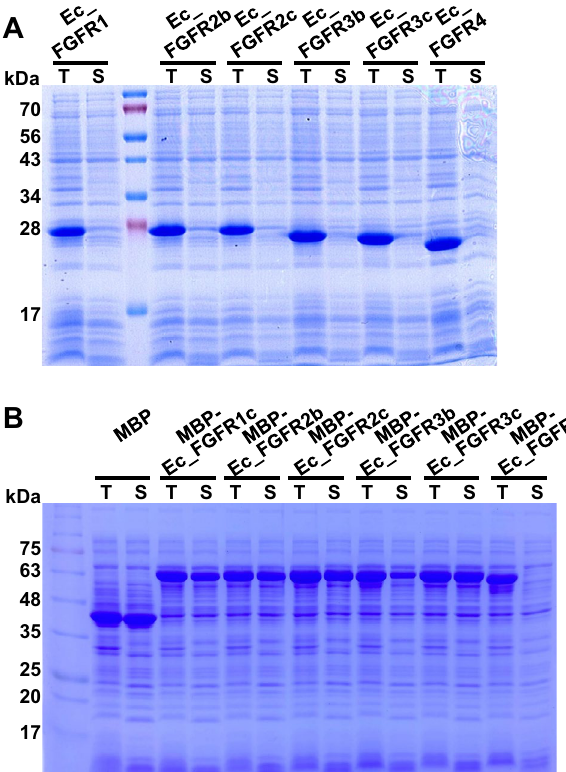
Figure 2. Analysis of 6× His- ( A ) and maltose-binding protein (MBP)-fused fibroblast growth factor receptor (Ec_FGFR) ( B ) proteins in Escherichia coli XL1-Blue via SDS-PAGE. All FGFR proteins (1c, 2b, 2c, 3b, 3c, and 4), consisting of minimal ligand-binding domains (D2 and D3) without D1 and D1–D2 linker, were expressed in E. coli XL1-Blue under the specified conditions described in the experimental section. T and S denote total and soluble fractions,